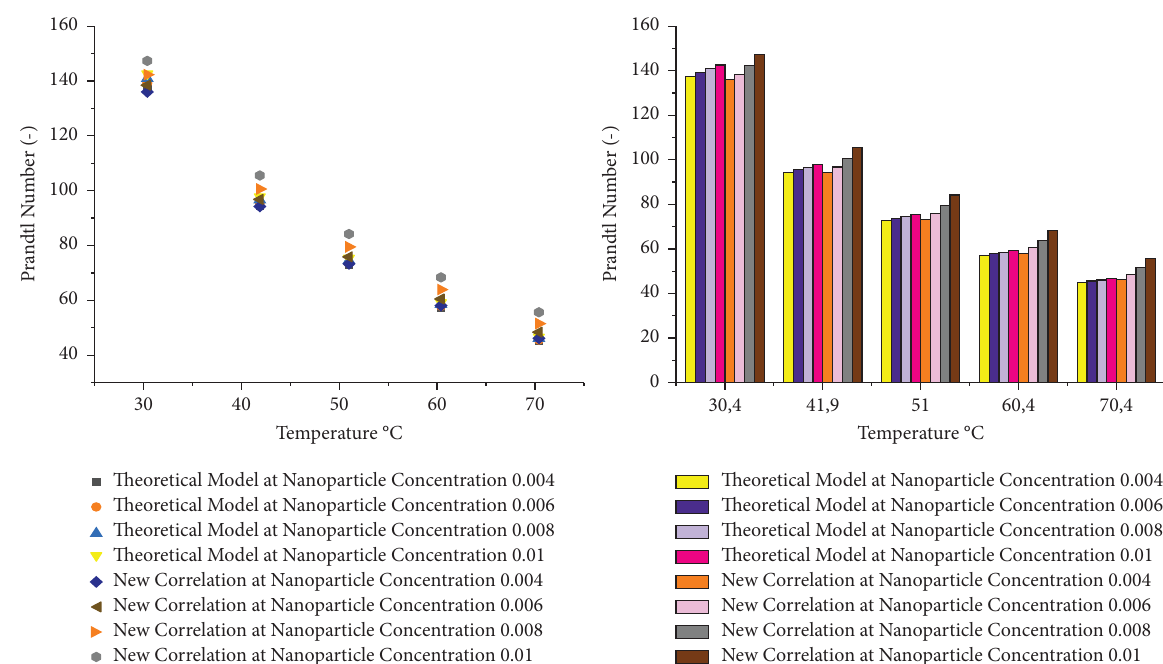
Figure 5: Comparison of titanium oxide-ethylene glycol nanofuid Prandtl number theoretical model and new correlation.